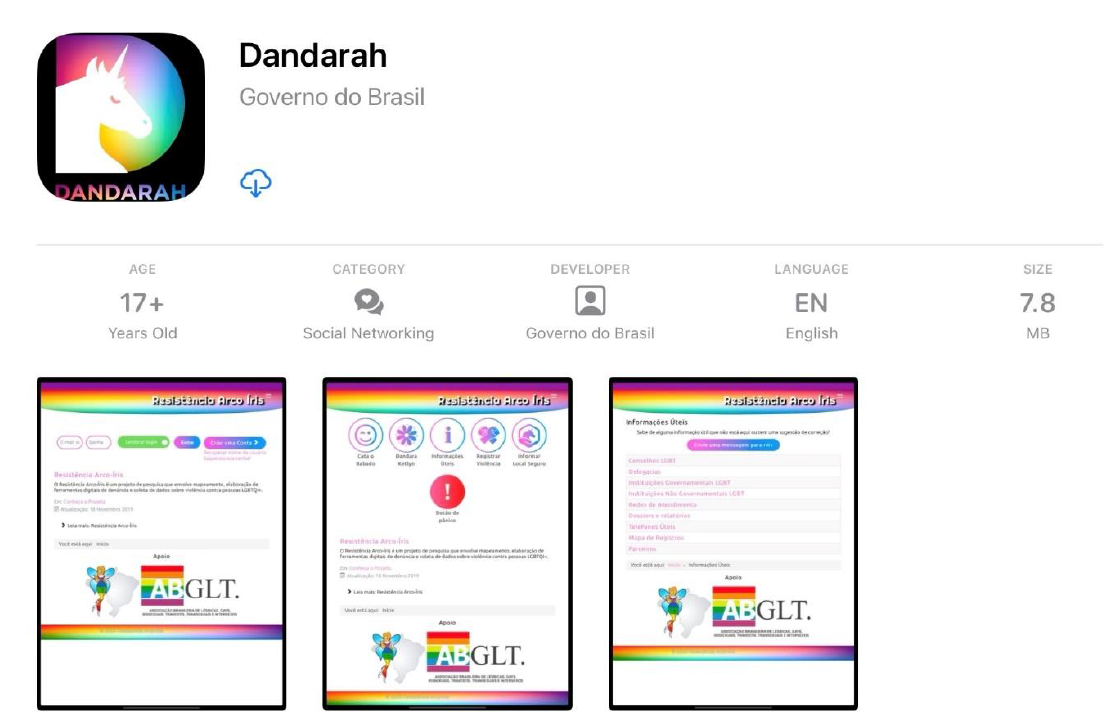
Figure 2. Rainbow Resistance: Dandarah App.